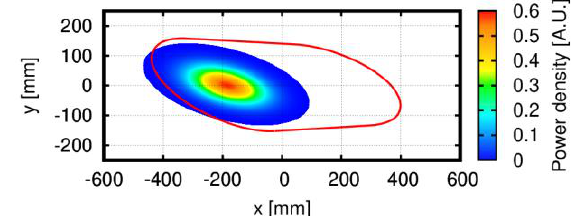
Fig. 11. Footprint of the beam U1 on the mirror UA. The contour is shown in red